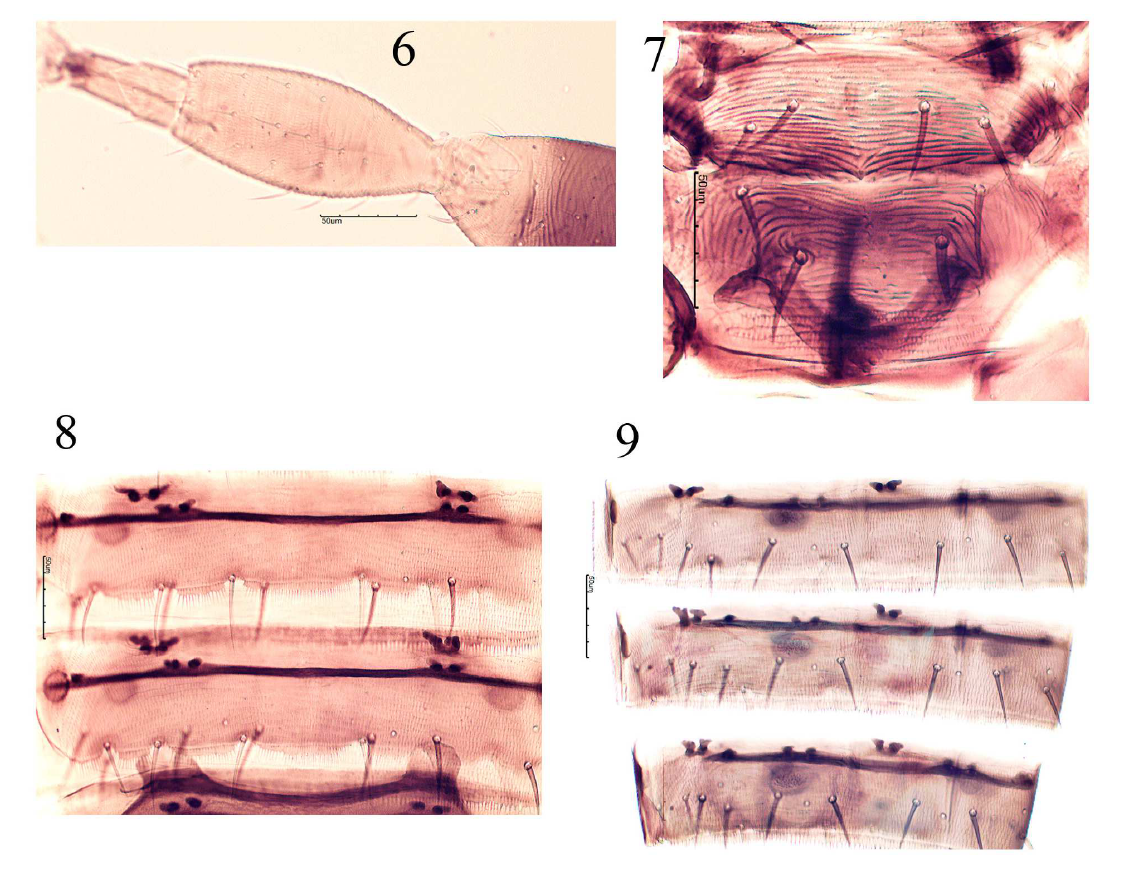
F IGURES 6–9. Sericothrips bicornis (6) fore leg (female); (7) mesonotum and metanotum (female); (8) Abdominal tergites 5-6 (female); (9) Abdominal tergites 5-7